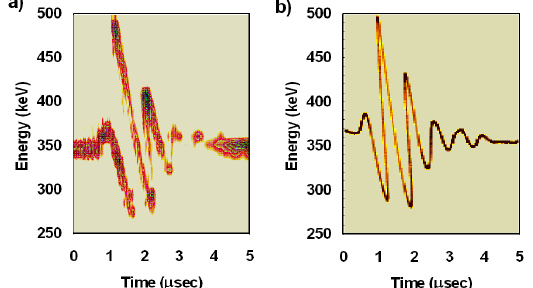
FIG. 5. Voltage waveform measured at the exit of the helix. The voltage and time interval associated with the first full peak- to-peak swing are 33 kV and 300 ns, respectively.